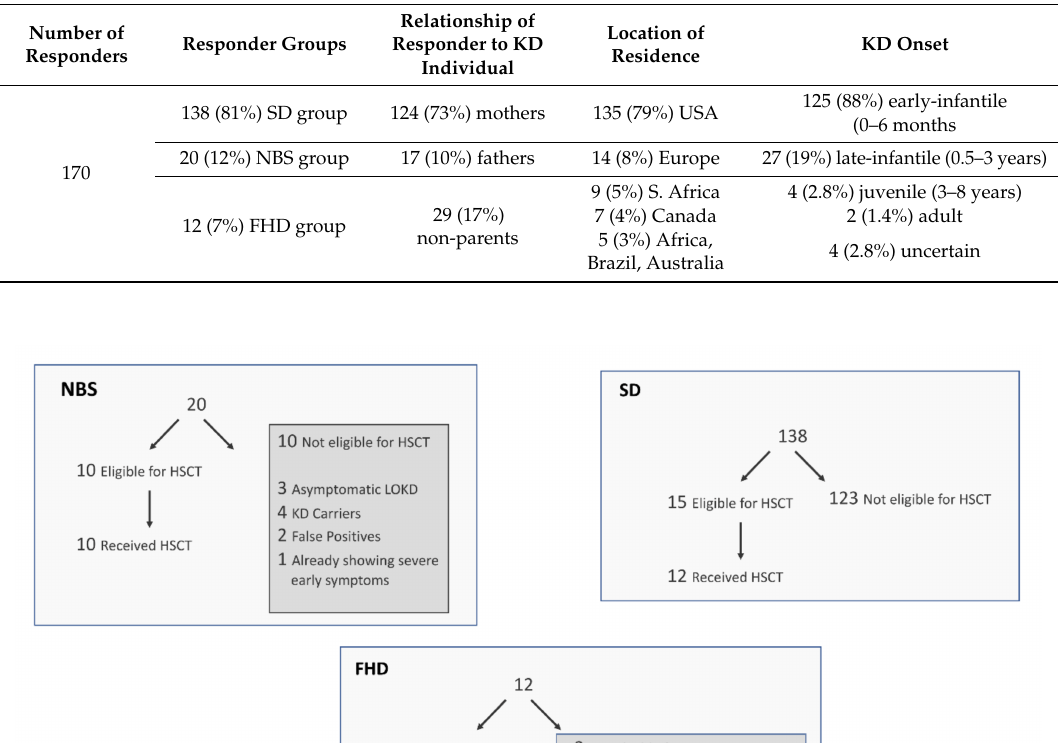
Table 1. Summary of survey responses from 170 responders. KD—Krabbe disease; SD—symptomatic diagnosis; NBS—newborn screening; FHD—family history diagnosis.